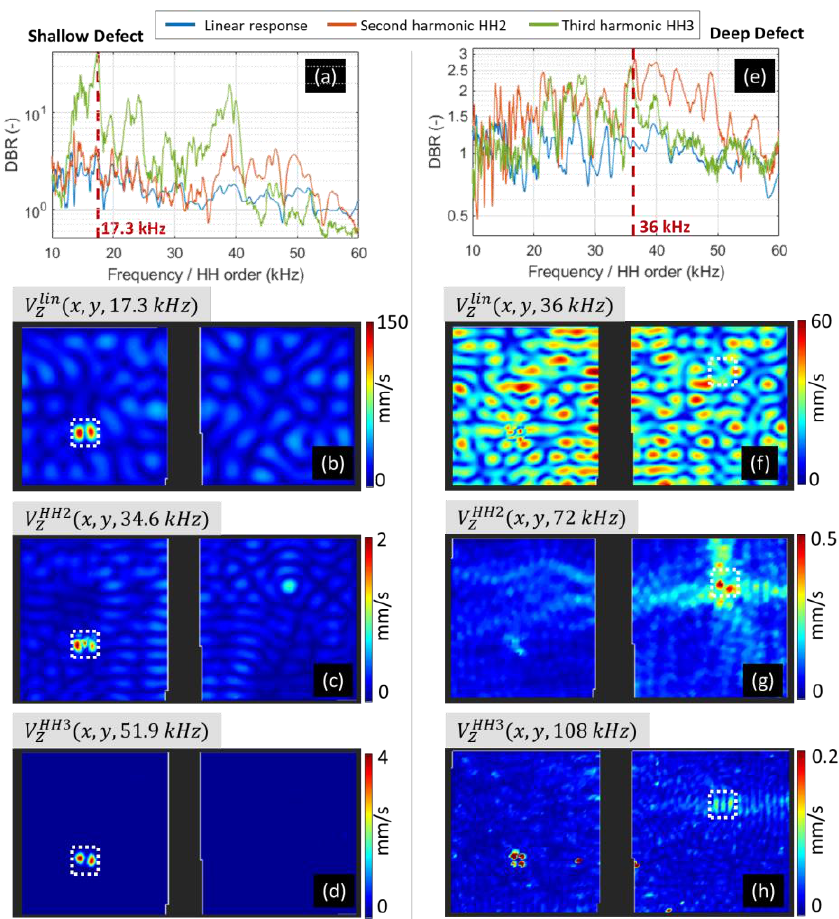
Figure 5. Defect-to-background ratio ( DBR ) curves for linear and nonlinear higher harmonic components with amplitude maps at local maxima. Results for ( a - d ) shallow delamination, and ( e - h ) backside-delamination.